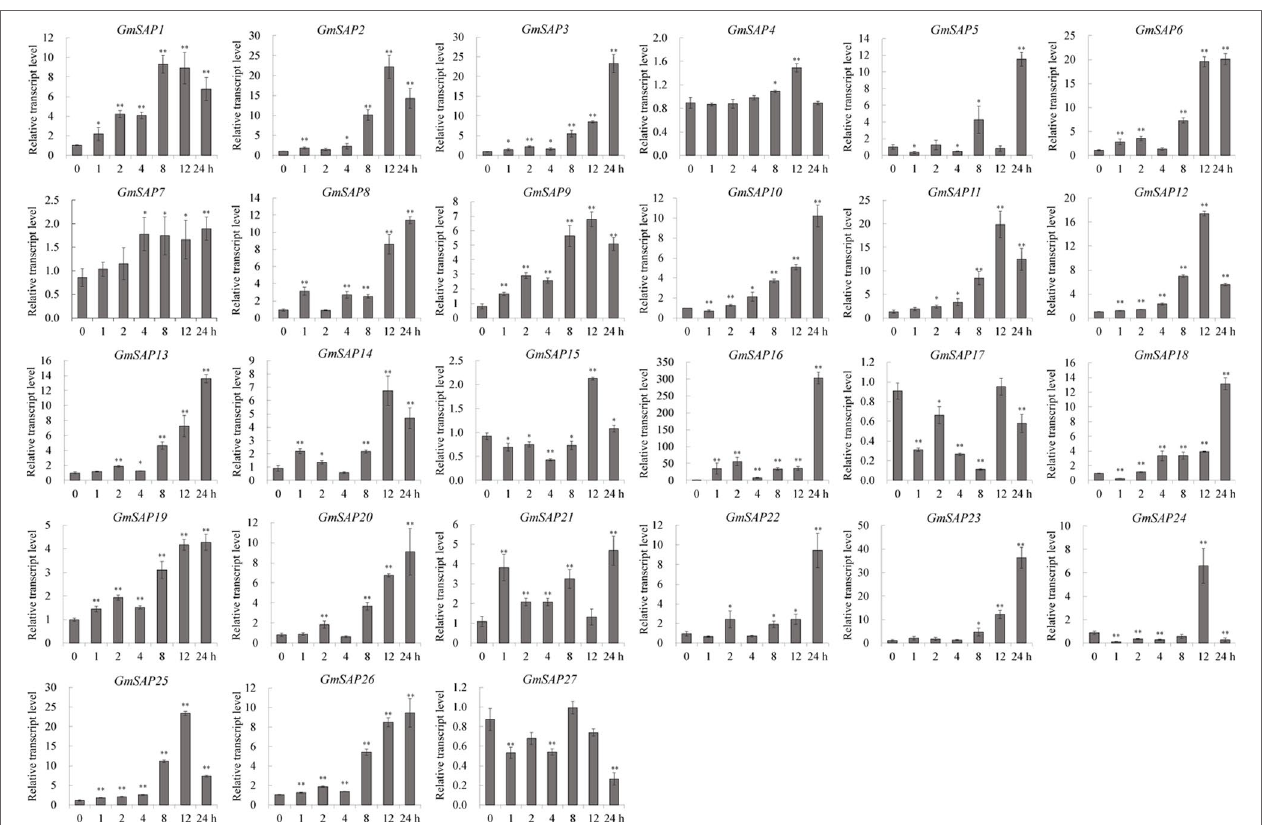
FiGURe 5 | Patterns of soybean stress associated proteins (SAPs) transcript accumulation under water deficit stress. The data were normalized to the soybean internal control gene GmCYP2 . Three biological replicates were performed, and the values are presented as the means ± SD. Asterisks indicate statistical significance (*, P 0.05; and **, P 0.01; Student’s t test) compared with the corresponding